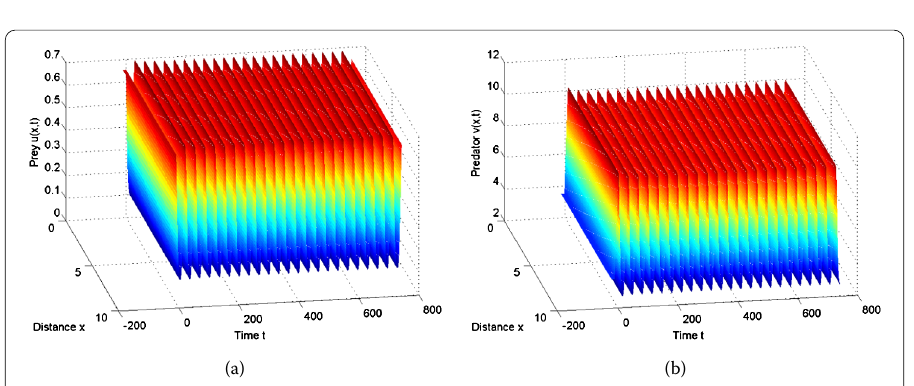
Figure 4 Numerical simulations of system (1.2) for a = 10, β = 0.01, d 1 = 0.1, d 2 = 10, b = 0.1, δ = 0.2. The positive equilibrium E ∗ of (1.3) becomes unstable and there exist spatially homogeneous periodic solutions with the initial value